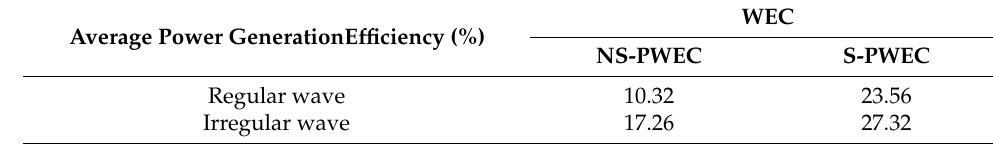
Figure 13. Array S-PWEC model layout diagram.